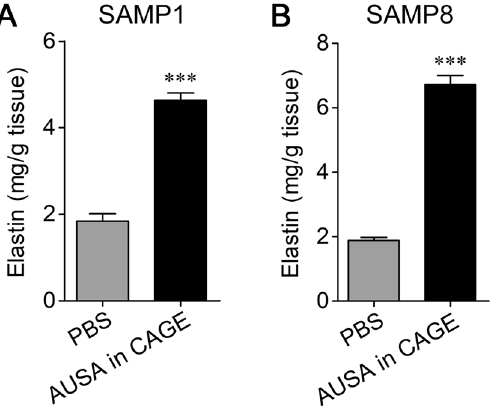
Figure 3. Enhancement of elastin expression by sialidase in SAMP1 and SAMP8. Elastin levels in the skin of SAMP1 ( A ) and SAMP8 ( B ) were measured after applying AUSA in CAGE or PBS on the skin twice a day for